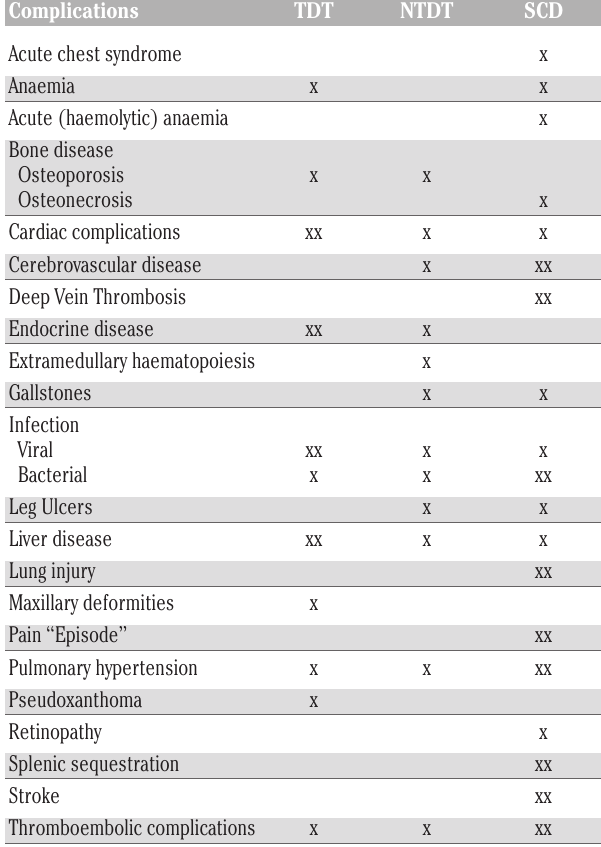
Table 1. Complications frequently observed in TDT/NTDT and